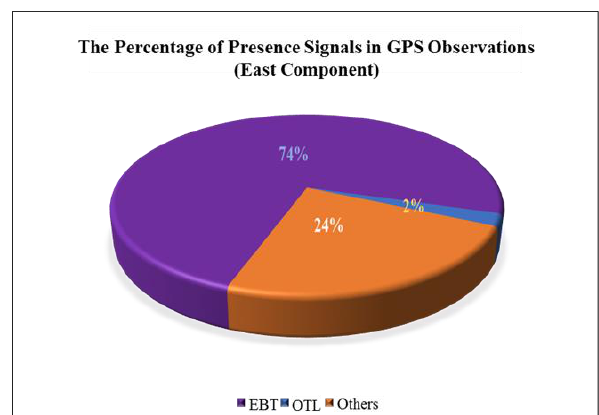
Figure 3. The fitting points between two configurations.